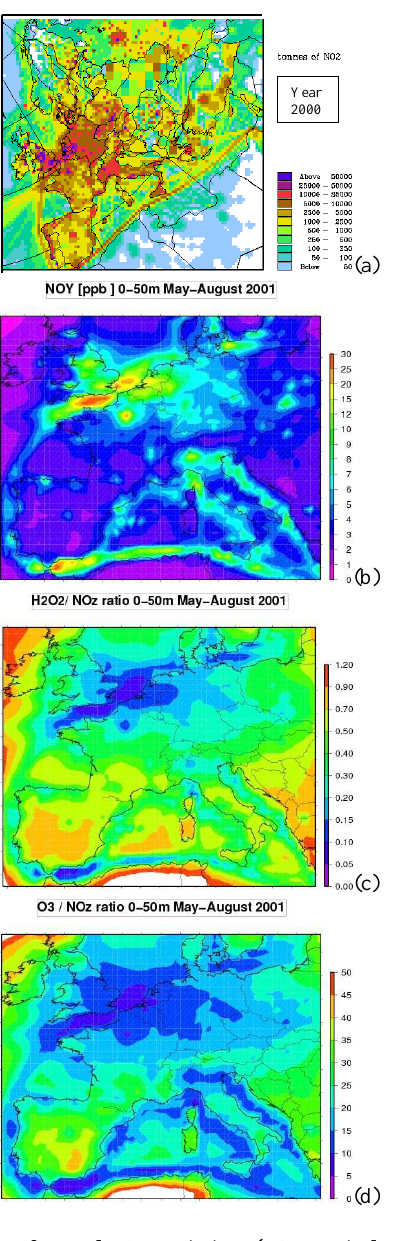
Fig. 3. Maps of annual NO x emissions (NO 2 equivalent) for year 2000 per 50 × 50km 2 grid cells, from EMEP (a) , chemical regime indicator concentration or ratios (averaged over summer 2001): (b) NO y [ppb], (c) H 2 O 2 /NO z ratio, (d) O 3 / NO z ratio.